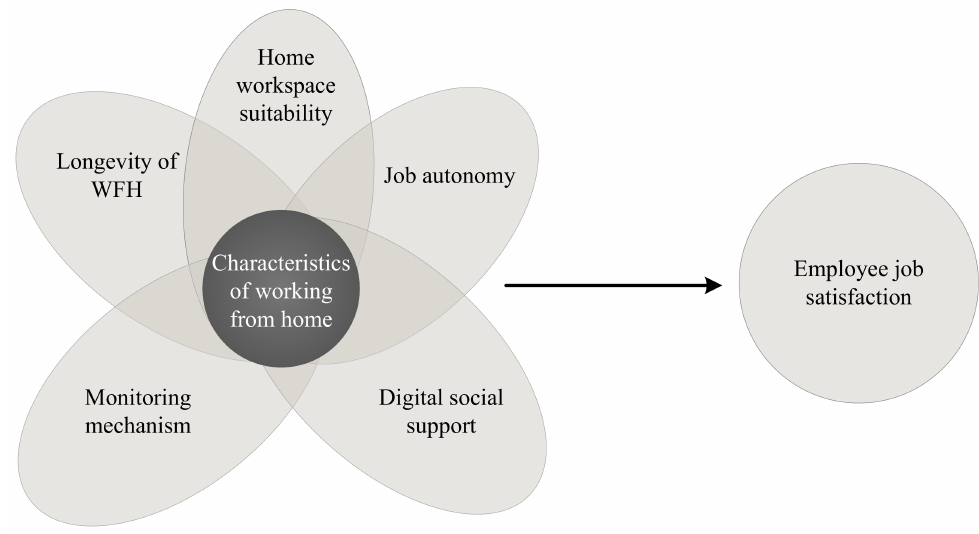
Figure 1. Research